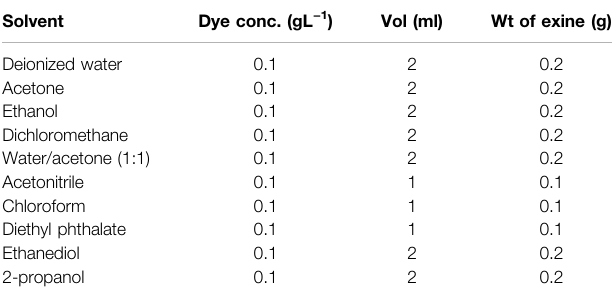
TABLE 2 | Details of dye solvent used concentration, volume added to column and weight of exine. Solvent Deionized